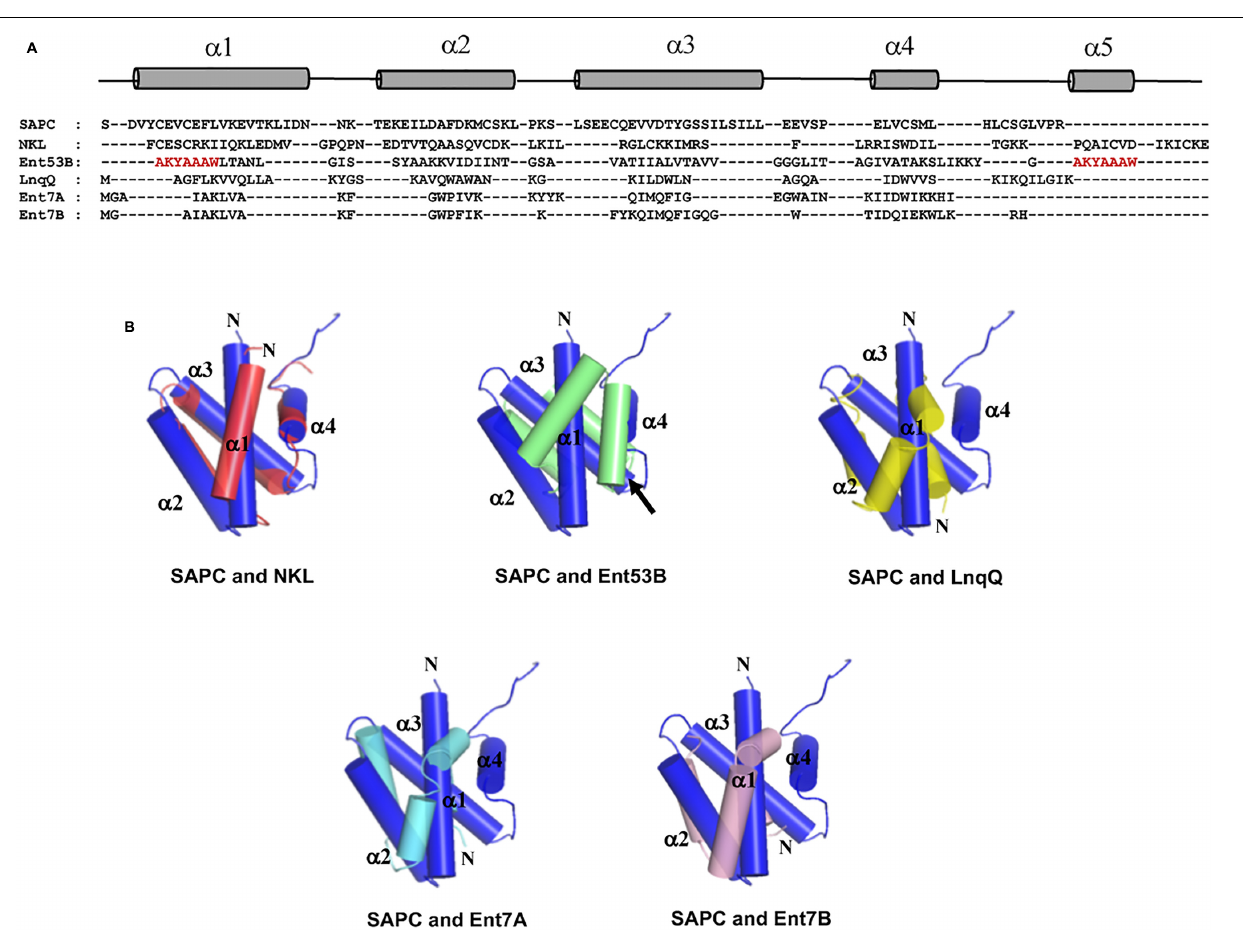
FIGURE 6 | Sequence and structure alignment of representative peptides of saposin fold exhibiting bacteriocins; enterocin NKR-5-3B (Ent53B), lacticin Q (LnqQ), enterocin 7 (Ent7A and 7B), saposin and saposin-like peptide. (A) Sequence alignment highlighting the helical and coil regions of these peptides as represented by the cylinder and line symbols, respectively, (B) pair-wise superimposition of the structure of saposin C (SAPC; blue) with the structures of NK-lysin (NKL; red), enterocin NKR-5-3B (Ent53B; green), lacticin Q (LnqQ; yellow–green), enterocin 7 (Ent7A; cyan and 7B; pink). The helices are numbered accordingly with SAPC as the reference. The N-termini of the peptides and the ligation site of Ent53B are indicated by the letter N and an arrow, respectively. In the case of Ent53B the region in the “fifth helix” is repeated in the first helix (amino acid sequence are colored red) due to the N- and C-terminal ligation. Images are generated using PyMol Molecular Graphics